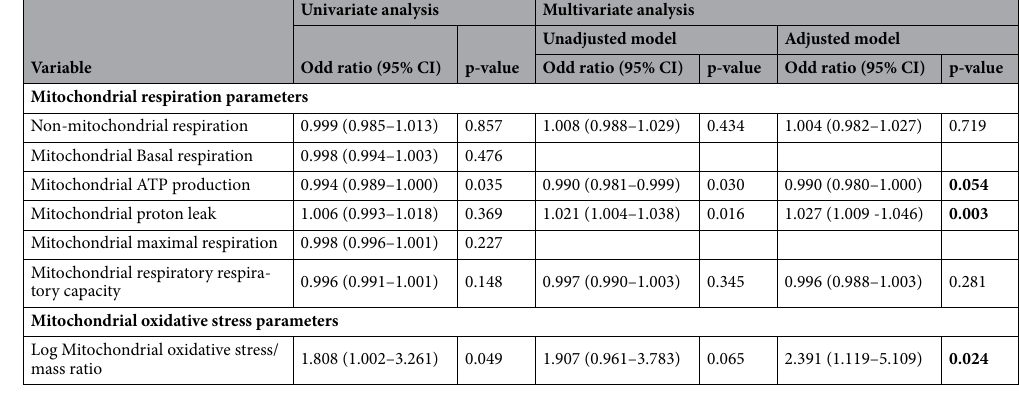
Table 3. Binary logistic regression analysis of association between mitochondrial respiration parameters and mitochondrial oxidative stress parameters with odds to become MCI. Mitochondrial respiration parameters and mitochondrial oxidative stress parameters was used in binary logistic regression model as independent variable. In adjusted model, age, sex, education level, eGFR, albumin/globulin ratio, waist to hip ratio, plasma glucose, systolic blood pressure, diastolic blood pressure, triglyceride, HDL-C, and LDL-C were added into the model as covariate. Bold values represent a statistical significance. ATP adenosine triphosphate, CI confidential interval, HDL-C high-density lipoprotein cholesterol, LDL-C low-density lipoprotein